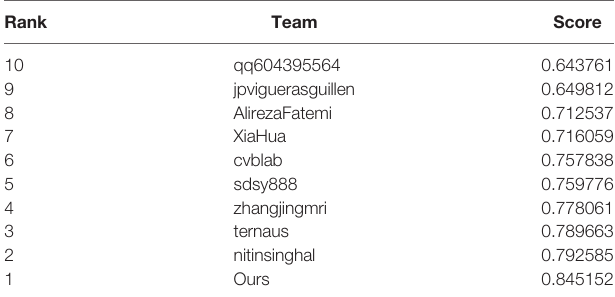
TABLE 1 | Task 1: pixel-level Gleason grade prediction.